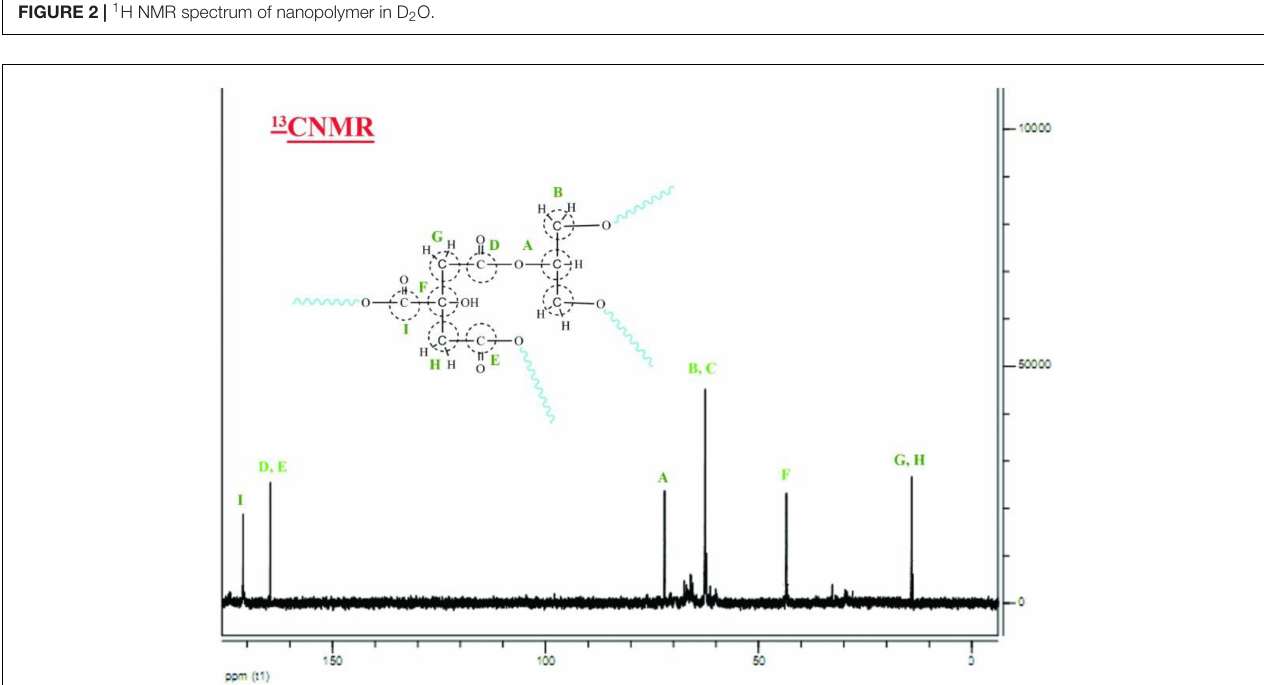
FIGURE 2 | 1 H NMR spectrum of nanopolymer in D 2 O.